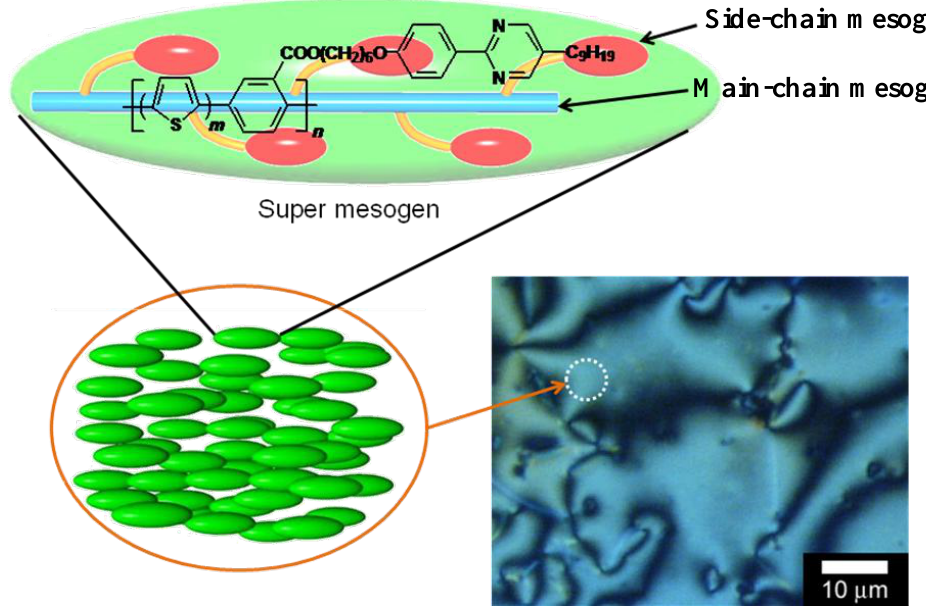
Figure 11. A plausible structure of the main chain and side chain cooperation LC system (super